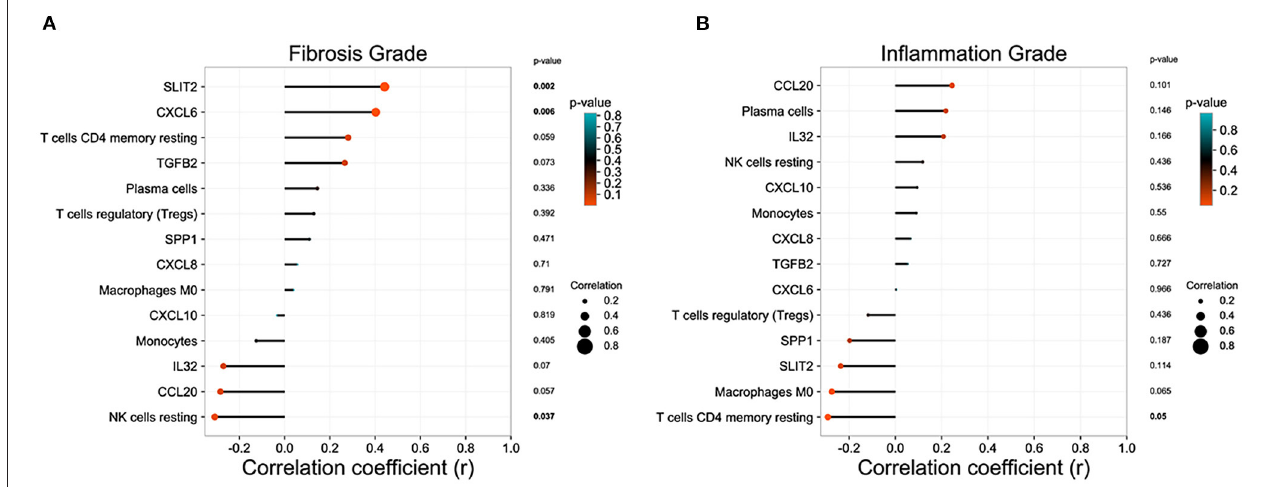
FIGURE 5 | Correlation analysis between the immune microenvironment and liver status in biliary atresia (BA). (A) Relationship between immune microenvironment and liver fibrosis grade in BA liver. (B) Relationship between immune microenvironment and liver inflammation grade in BA